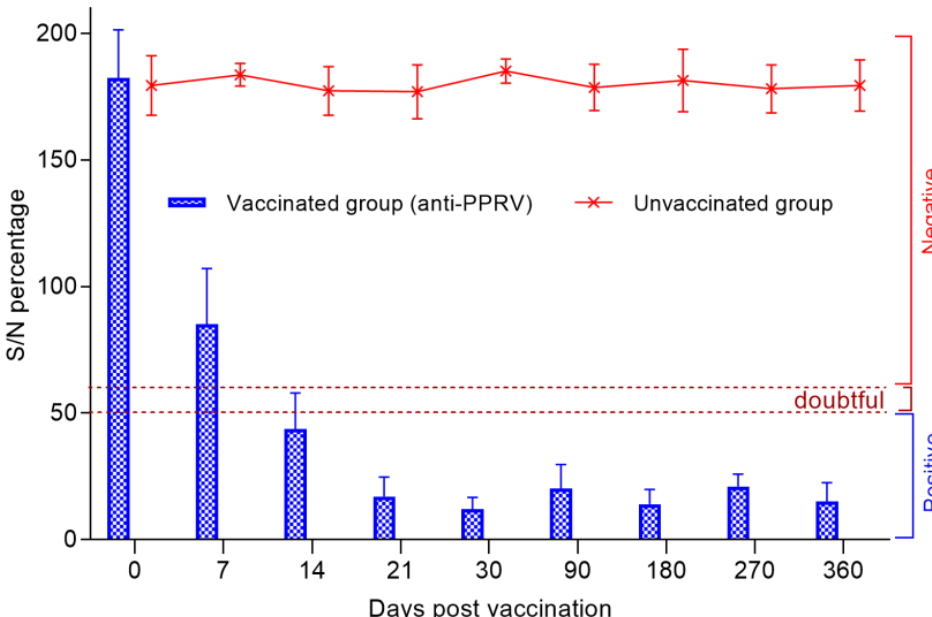
Figure 3. Evolution of the average percentage of inhibition (with standard deviation) in each group of vaccinated and control sheep during the experiment after a single vaccination. In the present study, the unit of measurement was S/N percentage, and it was assumed that a lesser S/N % meant higher antibody levels. S/N percentage of ≤ 50% was considered positive, while that of 50 < S/N ≤ 60% was considered doubtful. >60% S/N percentage was considered negative for the presence of antibodies against PPRV. All the results were recorded as Mean ± S.E.M.